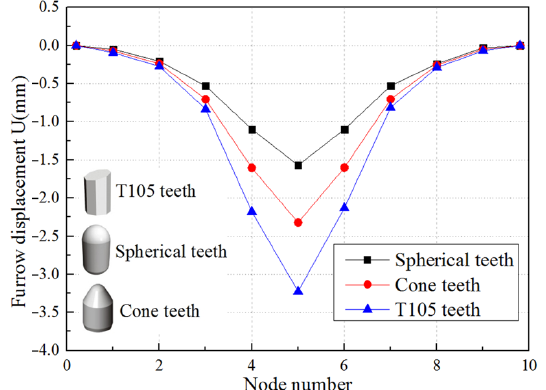
Figure 10. Displacement of single teeth.